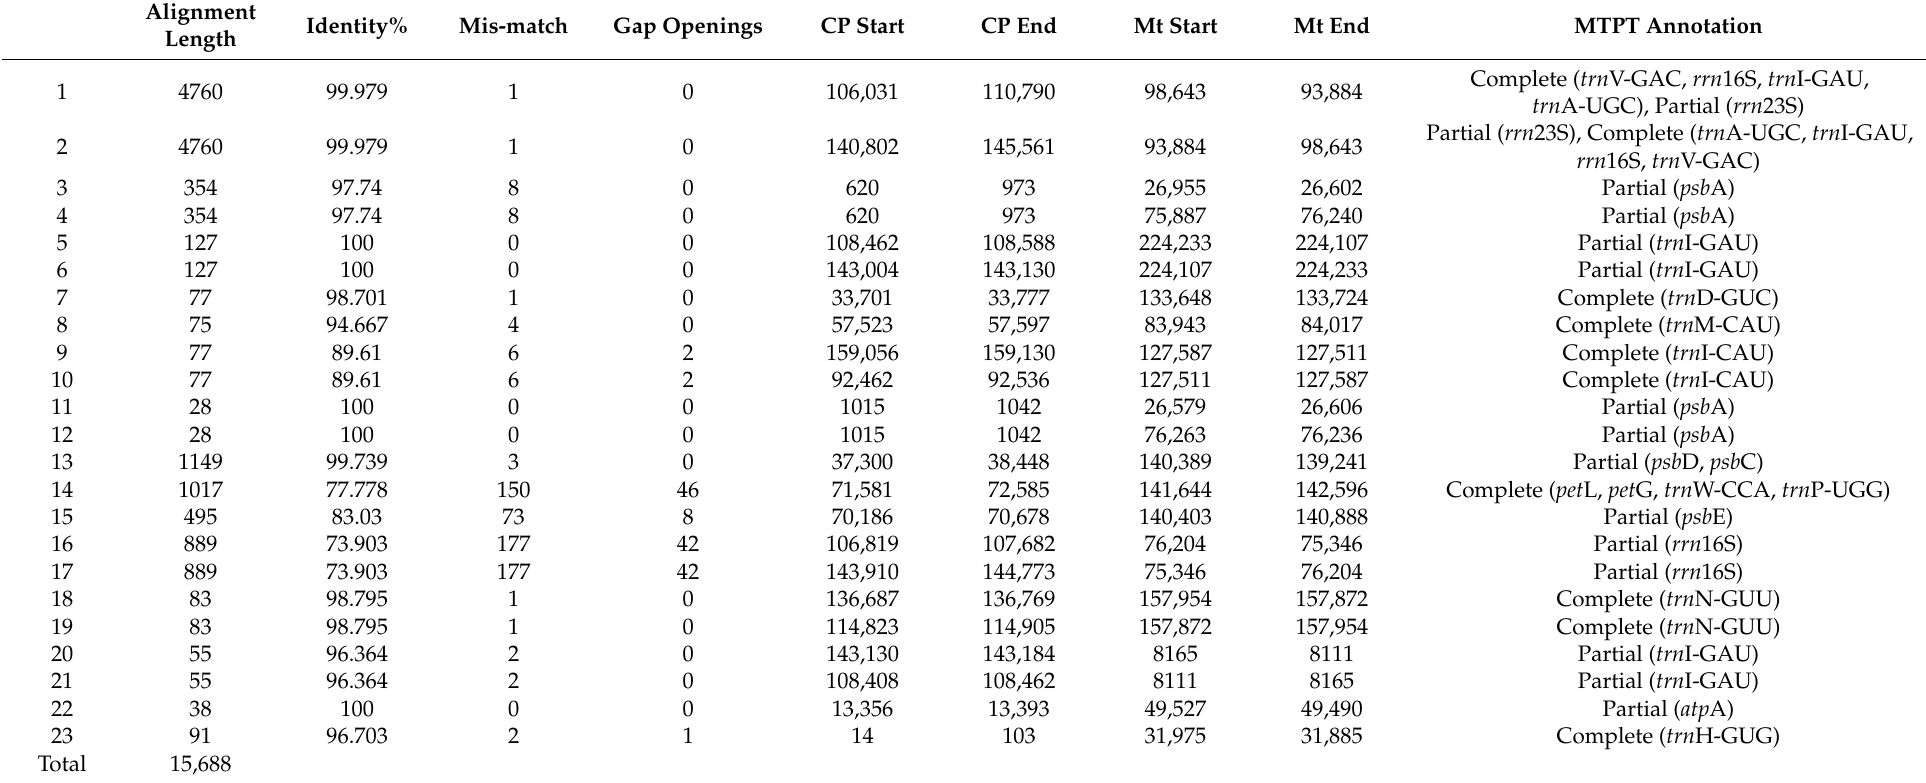
Table 2. Fragments transferred from chloroplasts to mitochondria in Q. acutissima